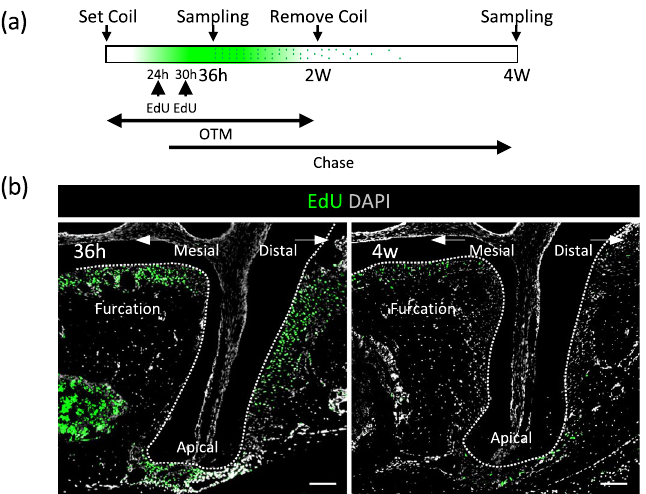
Figure 4. Fate of OTM-induced proliferating cells. ( a ) Schematic experimental schedule of proliferated-cell- tracing. EdU-labeled cells at 36 h after OTM were further traced for 4 weeks. ( b ) Proliferative cells were detected at the distal side of the distal root, apical, and furcation areas of the PDL (36 h). After 4 weeks of chasing, EdU- labeled cells disappeared completely at the distal side PDL of the distal root, whereas some EdU-labeled cells remained present at the apical and furcation areas of the PDL (4 weeks). Bar: 200 μm.